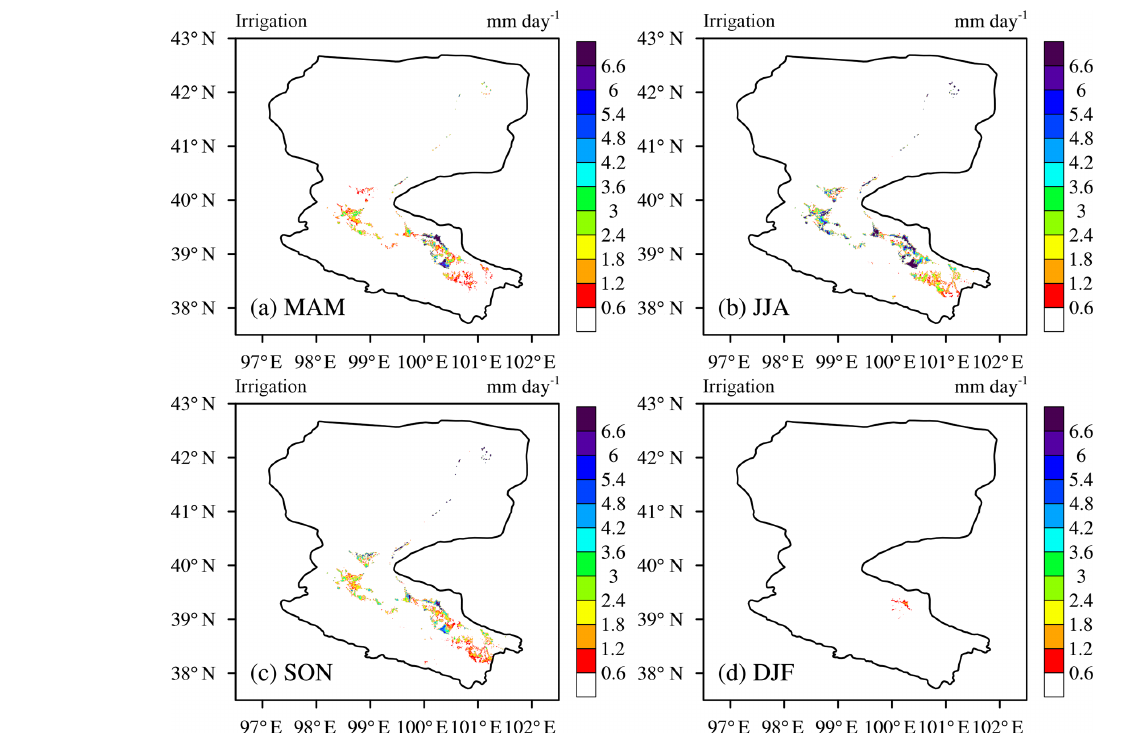
Figure 3. Climatological spatial distribution of the irrigation rate from monthly irrigation datasets in (a) spring, (b) summer, (c) autumn, and (d) winter from 1981 to 2013.